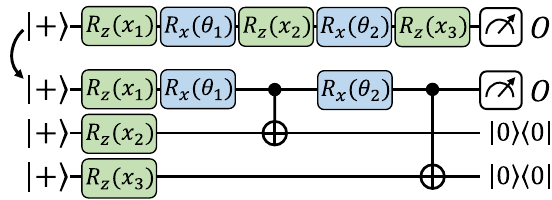
Fig. 4 | An exact mapping from a data re-uploading model to an equivalent explicitmodel,usinggateteleportation. Thedetailsofthismapping,aswellasits more elaborate form (using nested gate teleportation), can be found in Supple- mentary Section